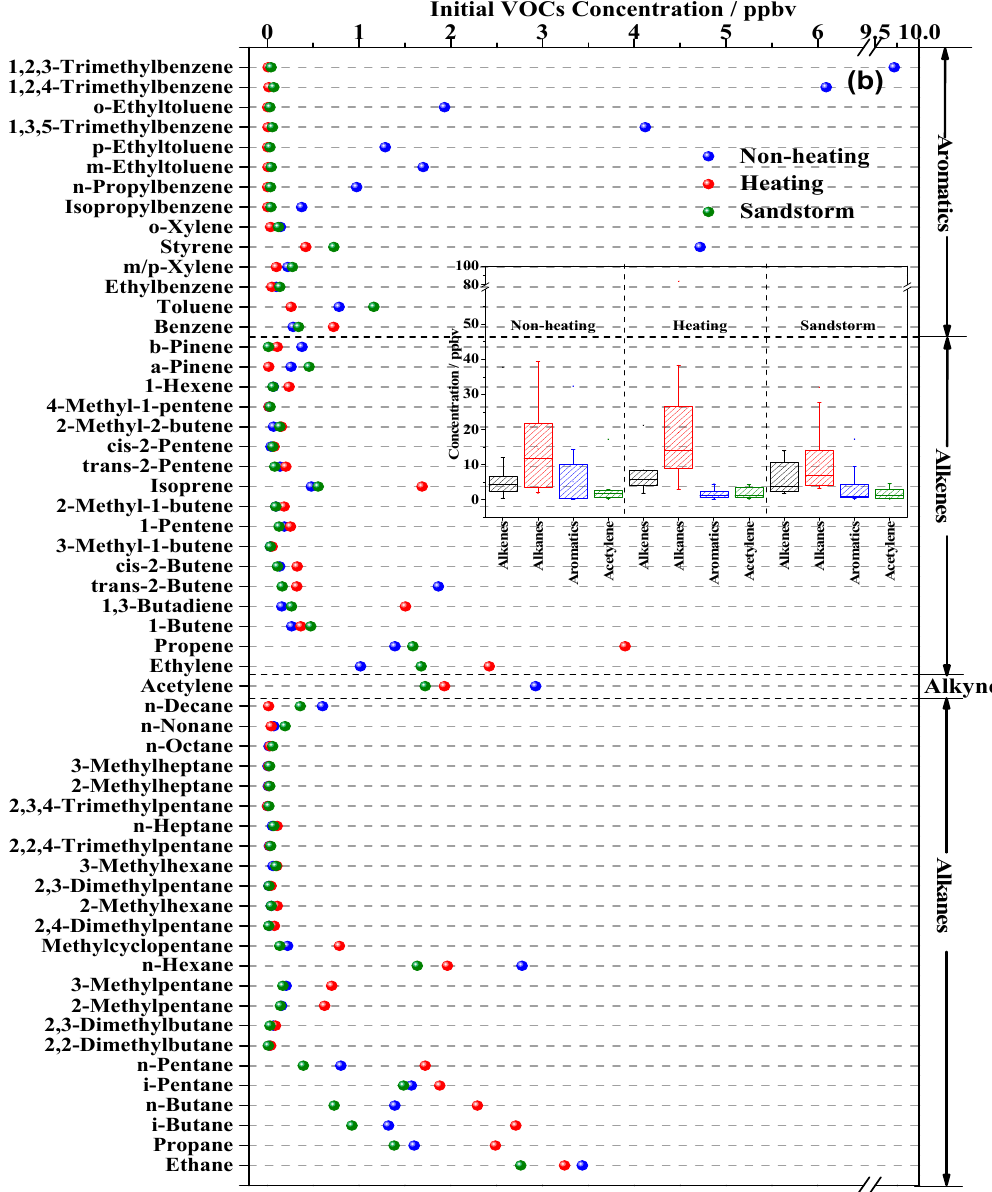
Figure 2. The ( a ) observed concentrations and ( b ) initial concentrations of 57 volatile organic compounds (VOCs) during the non-heating, heating, and sandstorm periods. The inset illustrations represent the observed and initial concentrations of alkenes, alkanes, aromatics, and alkynes during the three sampling periods. Table 1. Observed VOC concentrations compared among major cities in China.